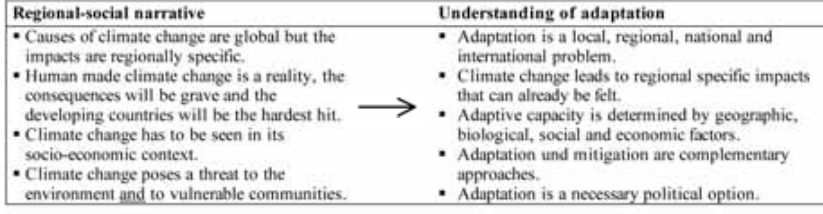
Table 3: Elements of a regional-social climate